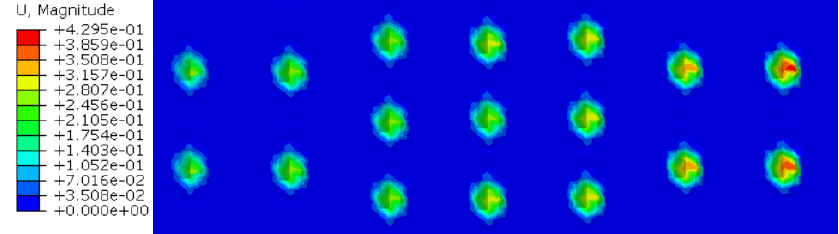
Figure 19. The strain distribution of casing wall (after optimization).